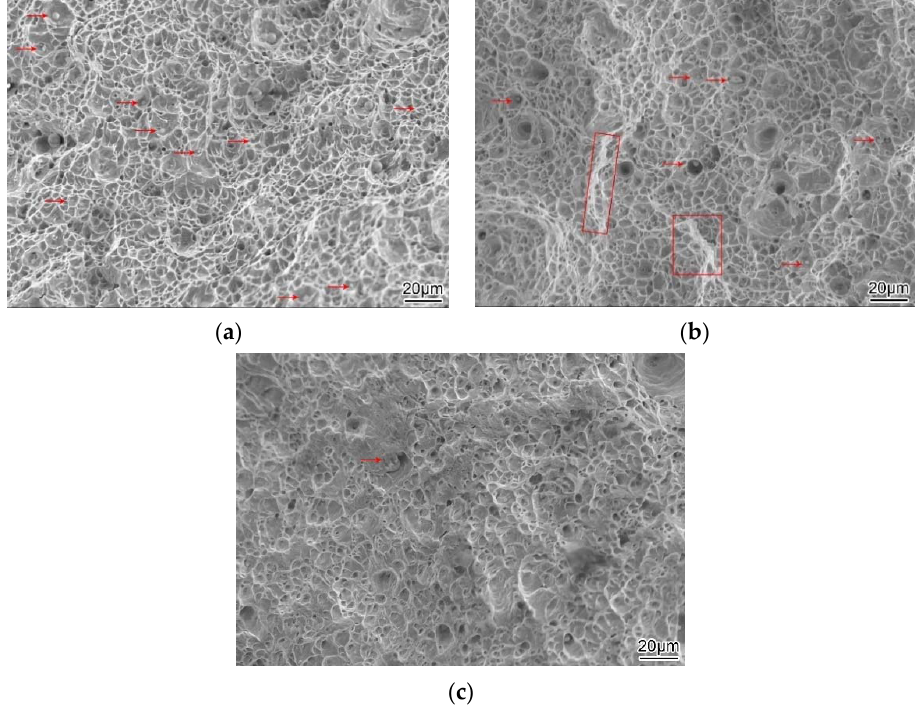
Figure 11. Morphology of tensile fracture of weld metal: ( a ) 0.21%Al; ( b ) 0.62%Al; ( c ) 1.05%Al. Figure 12 is the impact fracture micromorphology of the central area of 0.21% and